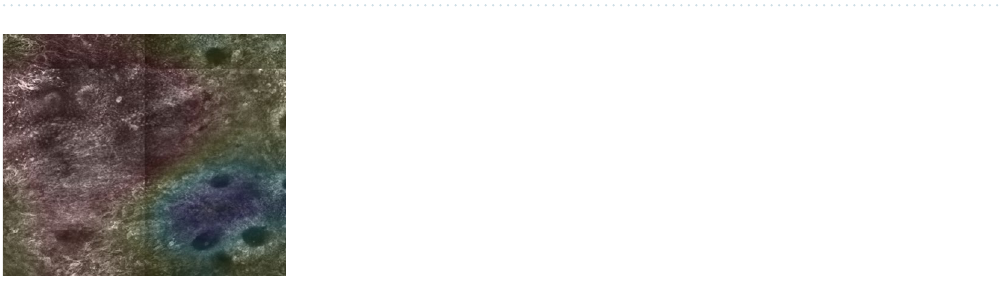
Figure 3. An example CAM for benign vs. aspecific classification. The CAM result is superimposed as a transparent color heatmap on the underlying greyscale RCM image. The model’s decision is aspecific, and the CAM highlights the contribution of each pixel to that decision. The blue-to-red color in the heatmap corresponds to low-to-high contribution (for the aspecific label), so the red areas correspond to where the aspecific regions are